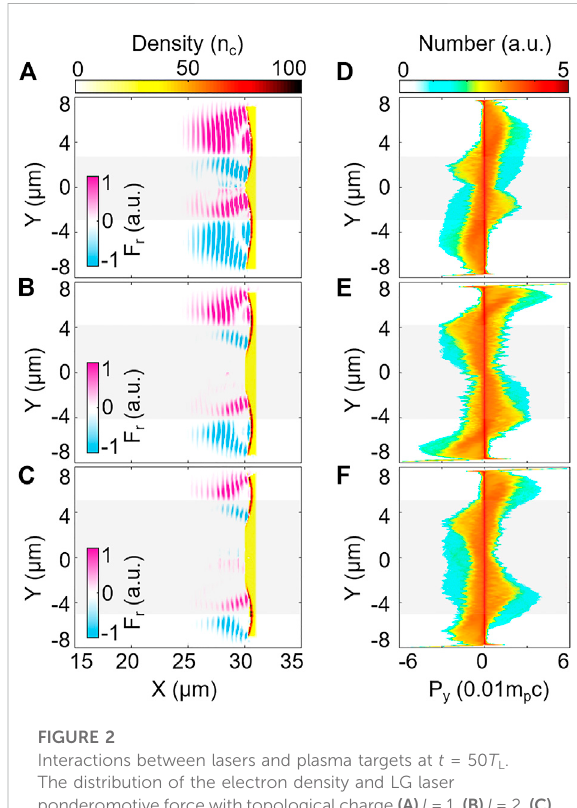
FIGURE 2 Interactions between lasers and plasma targets at t = 50 T L . The distribution of the electron density and LG laser ponderomotive force with topological charge (A) l = 1, (B) l = 2, (C) l = 3 are shown. The corresponding proton momentum distribution for the case with (D) l = 1, (E) l = 2, (F) l = 3 are compared. The gray bands represent the focusing